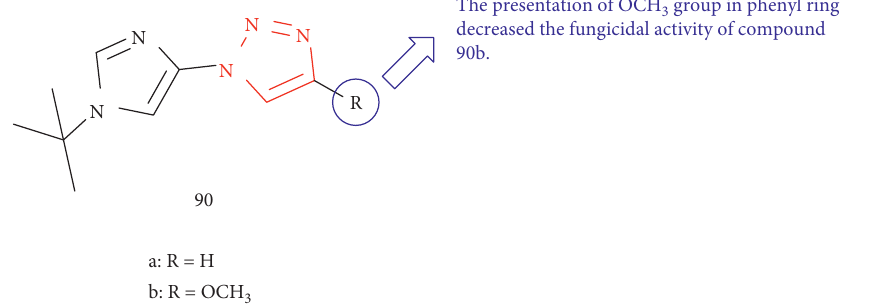
Figure 39: Chemical structure of some functionalized 1H-1,2,3-triazole tethered pyrazolo[3,4-b]pyridin-6(7H)-ones.